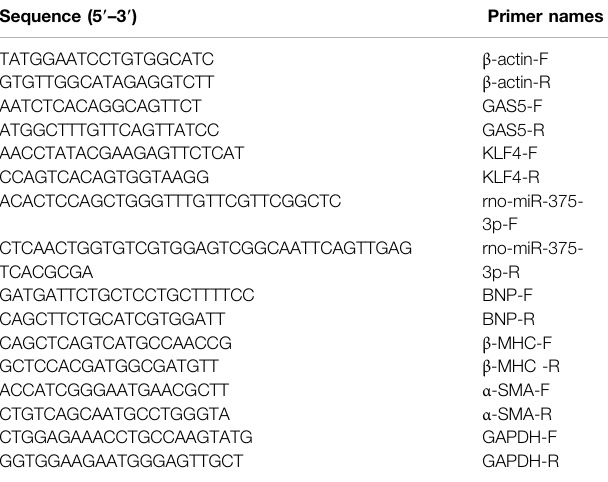
TABLE 1 | Primers for